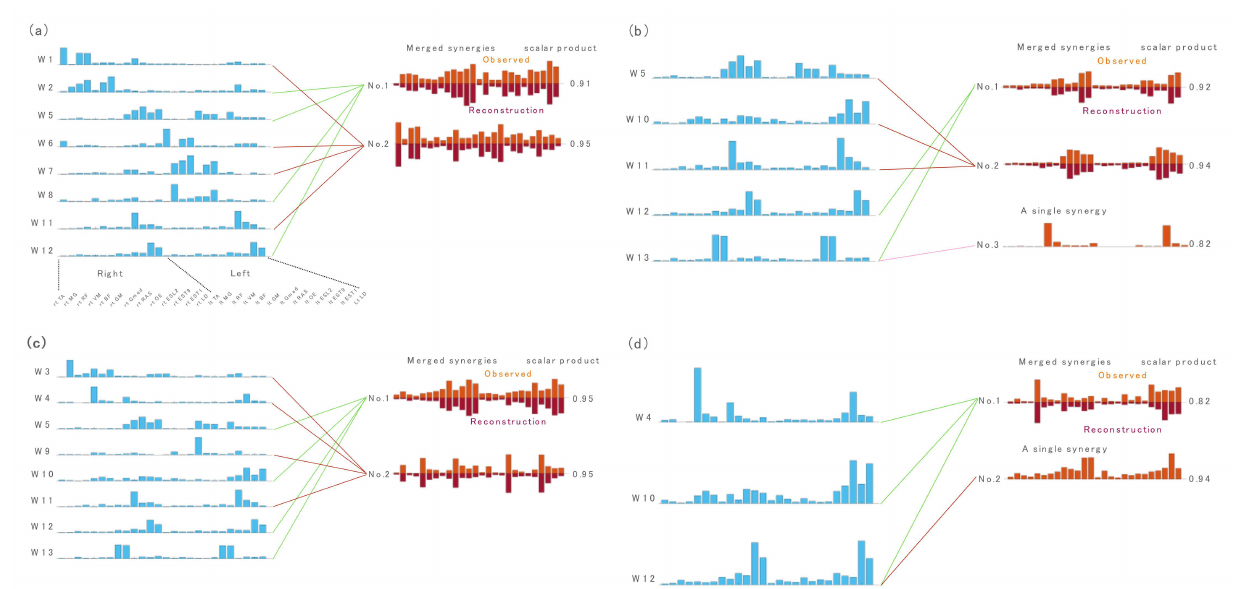
Figure 3. The relationship between muscle synergies of all tasks and muscle synergies of stability tasks including ( a ) left lunge, ( b ) cat-and-dog, ( c ) forward bend and ( d ) left rotation. The figures show the synergy cluster centroids of these task that could be explained by either a single or linearly combined multiple synergy cluster centroids of all tasks (synergies in blue) matched by maximizing scalar product > 0.75. Observed muscle synergies extracted from the single-task EMG (orange) and their reconstructions by merging their respective W1-combinations (dark orange) were further